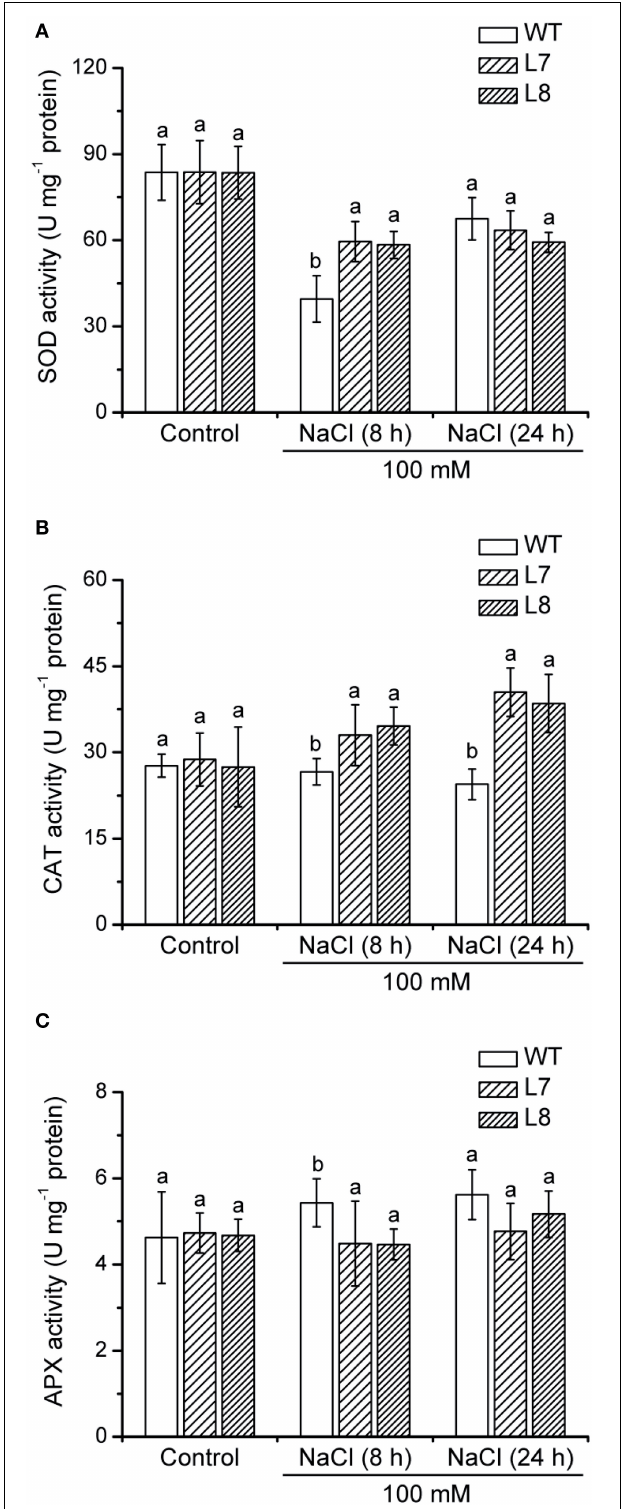
FIGURE 10 | Effect of NaCl on activities of antioxidant enzymes in wild-type tobacco and KcCSD -transgenic lines. Four-weeks old rooted plants of wild-type (WT) and transgenic lines (L7 and L8) were transferred